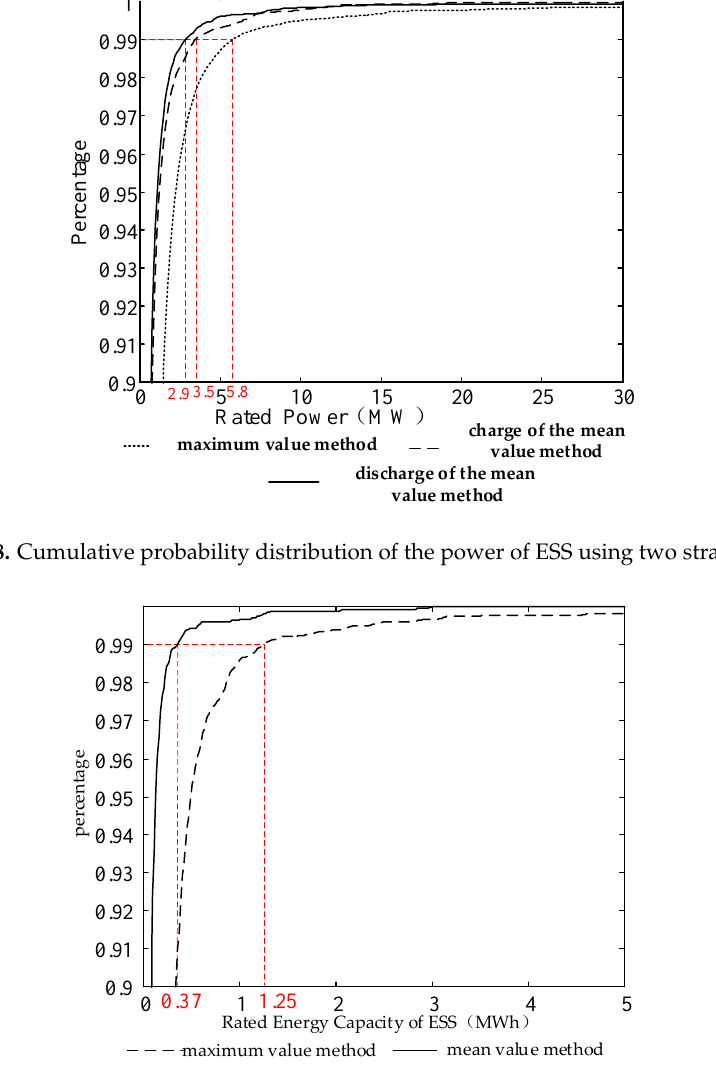
Figure 9. Cumulative probability distribution of energy of ESS in the two strategies. Table 3. The rated power and energy capacity of different control